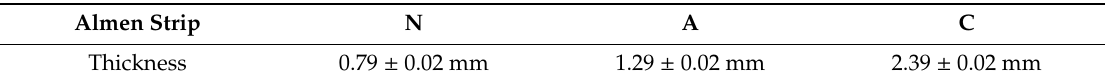
Figure 2. Fatigue test samples (DV-weld) shown in as-welded condition.